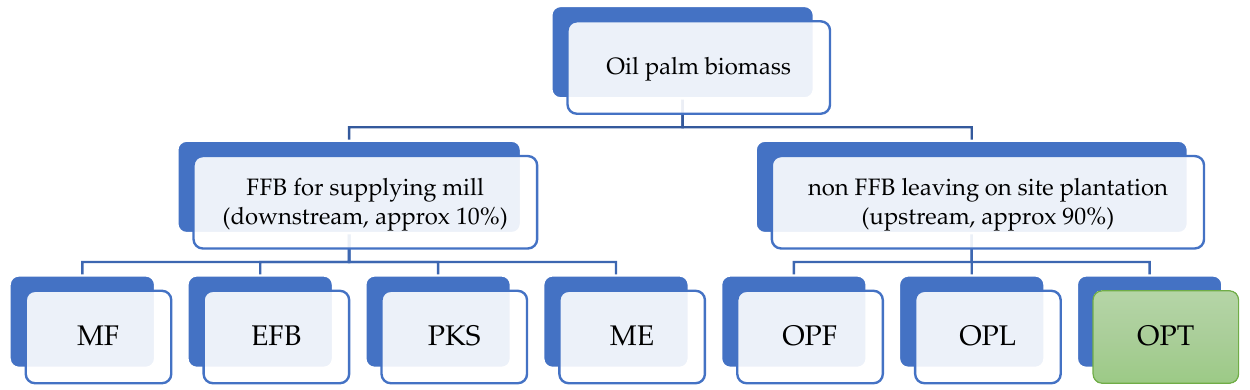
Figure 3. Biomass of oil palm that is generated both from downstream (fruit origin) and upstream (non-fruit). The focus of this study is OPT which shown in green color.